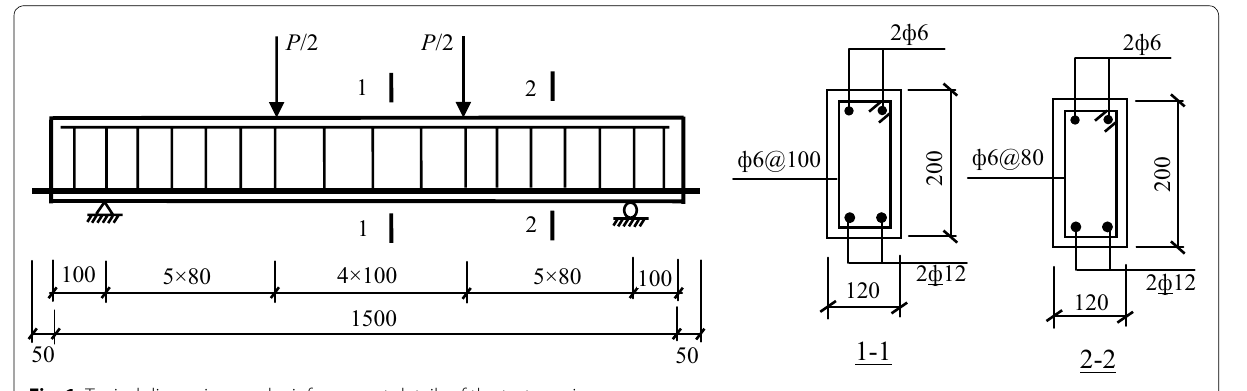
Fig. 1 Typical dimensions and reinforcement details of the test specimens.